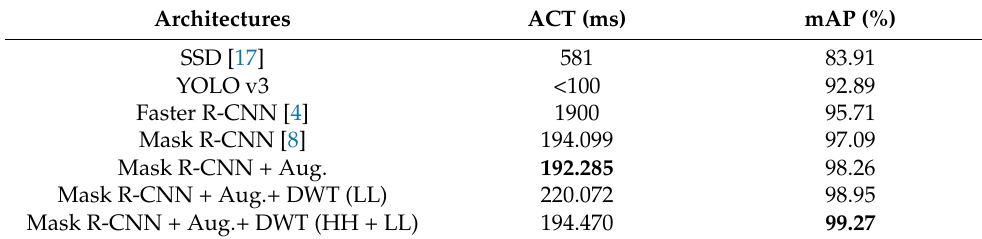
Table 6. Comparison of ACT and mAP for each algorithm.